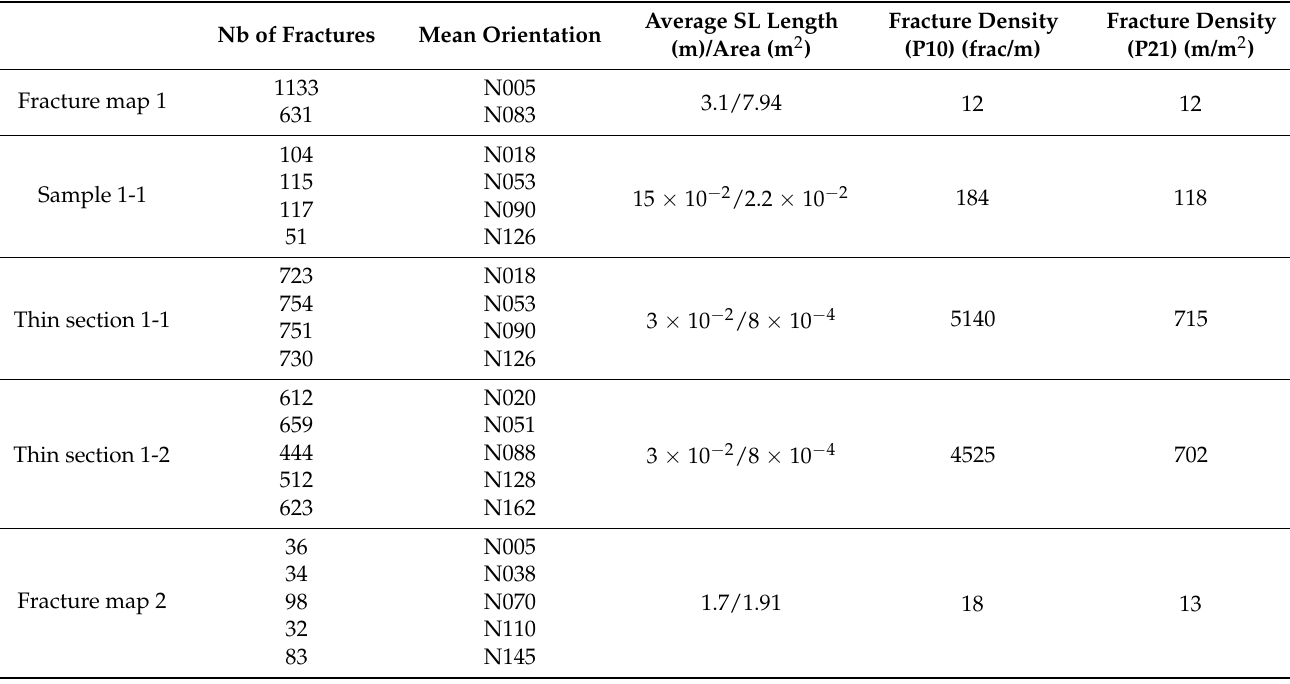
Table 2. Spatial statistics of 2D samples acquired from outcrop scale (fracture maps) to thin section scale. Two Scanlines (SL) at least were generated for calculating the fracture density (P10); the length average is